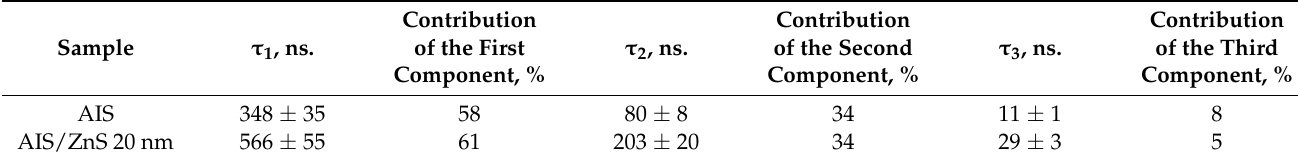
Table 2. Results of QDs AIS and AIS/ZnS the fluorescence decay kinetics.